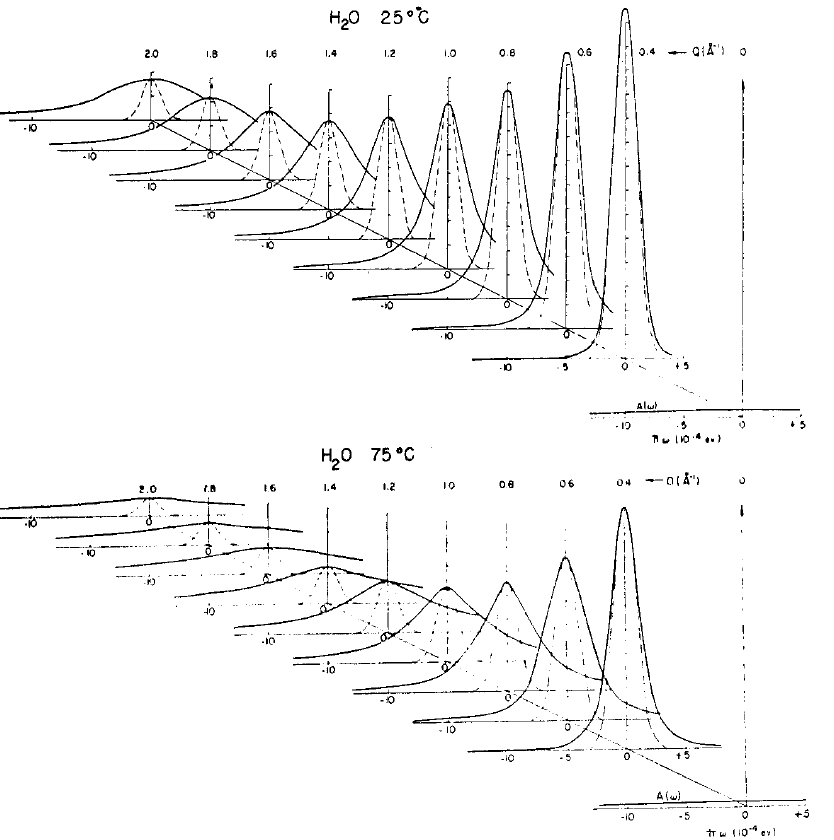
Figure 15. The scattering function S(Q, ω ) for H 2 O at 25 and 75 C for small values of energy transfer ħω as measured with an incident energy of 4.96 meV and an energy resolution of 0.2 meV obtained with the rotating crystal spectrometer. The resolution functions are shown as dashed curves. The multiple scattering A( ħω ) is also shown. This figure is taken from ref. Figure 1 of [50]. © (1962) The Physical Society of Japan.